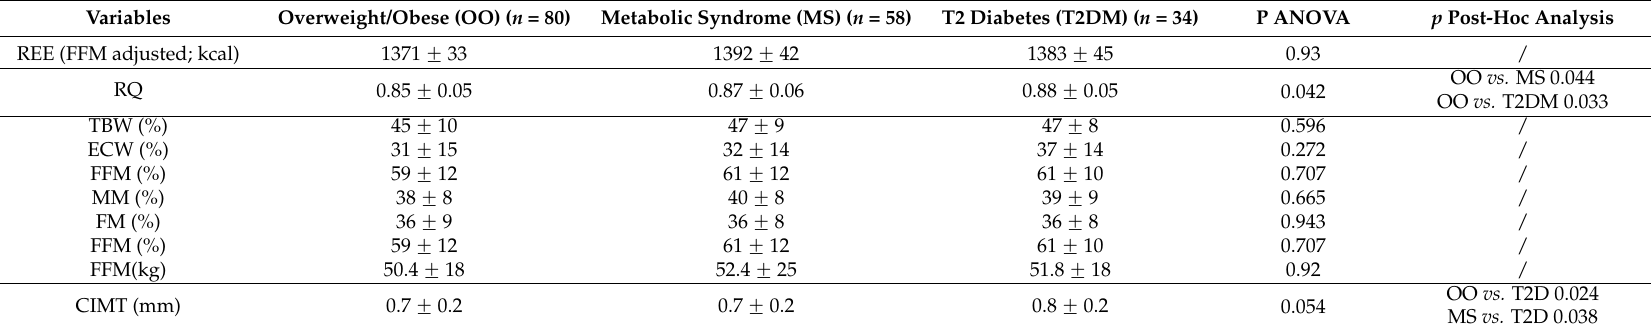
Table 2. Respiratory quotient, resting energy expenditure, body composition, and carotid intima-media thickness according to groups (Overweight/Obese, with Metabolic Syndrome, with Type 2 Diabetes Mellitus).